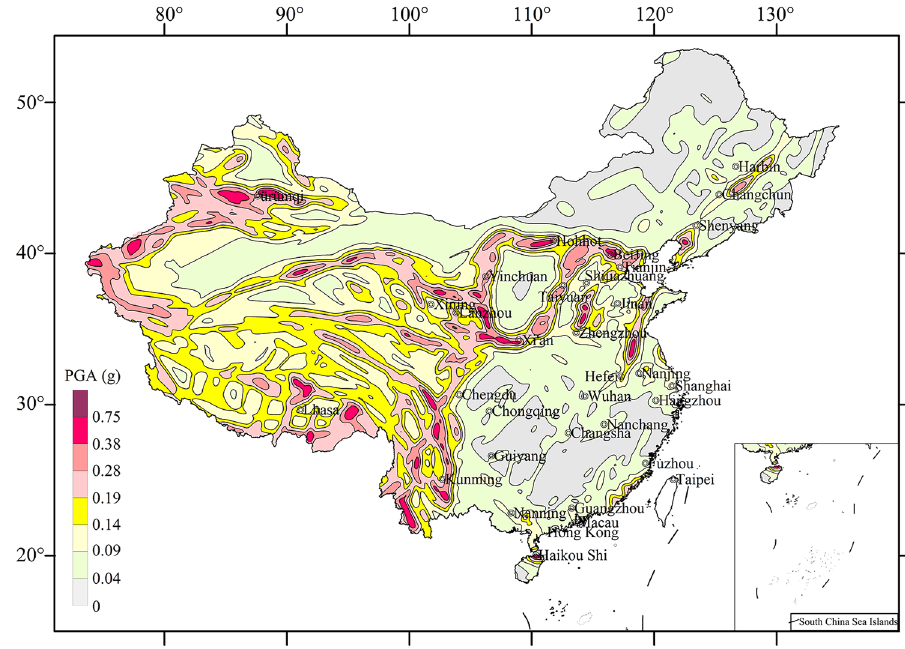
Fig. 6 Peak ground acceleration (PGA) with 10% probability of exceedance in 50 years calculated using the newly built seismicity model in this